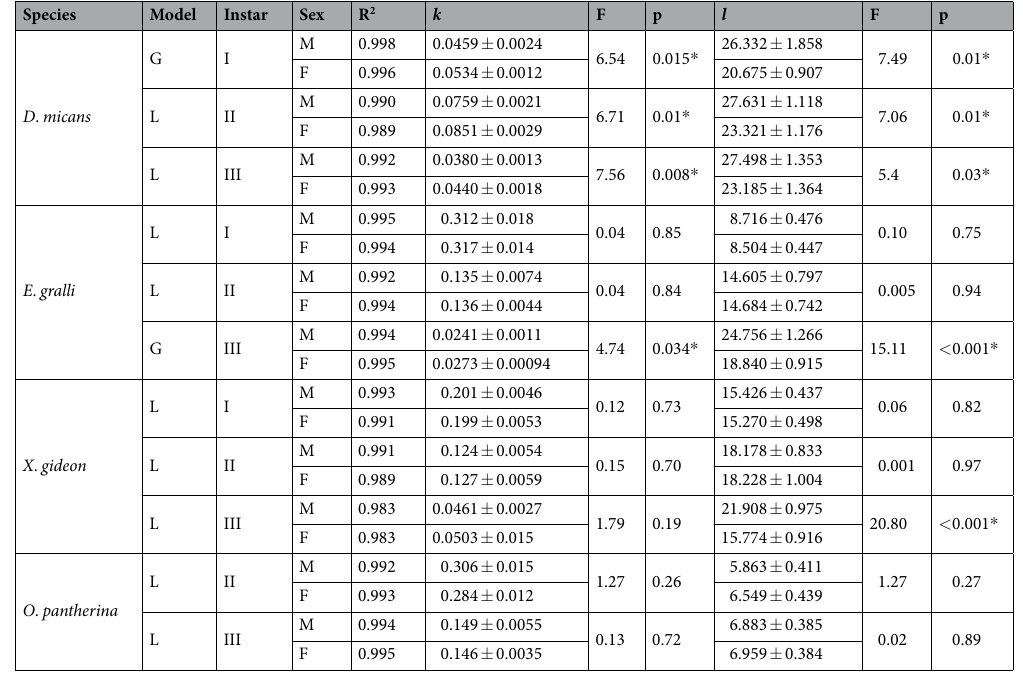
Table 4. Estimated growth rates ( k ) and inflection points ( l ) for all instars of four scarab species and the test of sexual differences in these parameters. Model refers to the chosen growth model according to total variance (R 2 ) explained by the model; L: logistic growth curve, G: Gompertz curve. The larvae of O . pantherina have not been weighed in the first